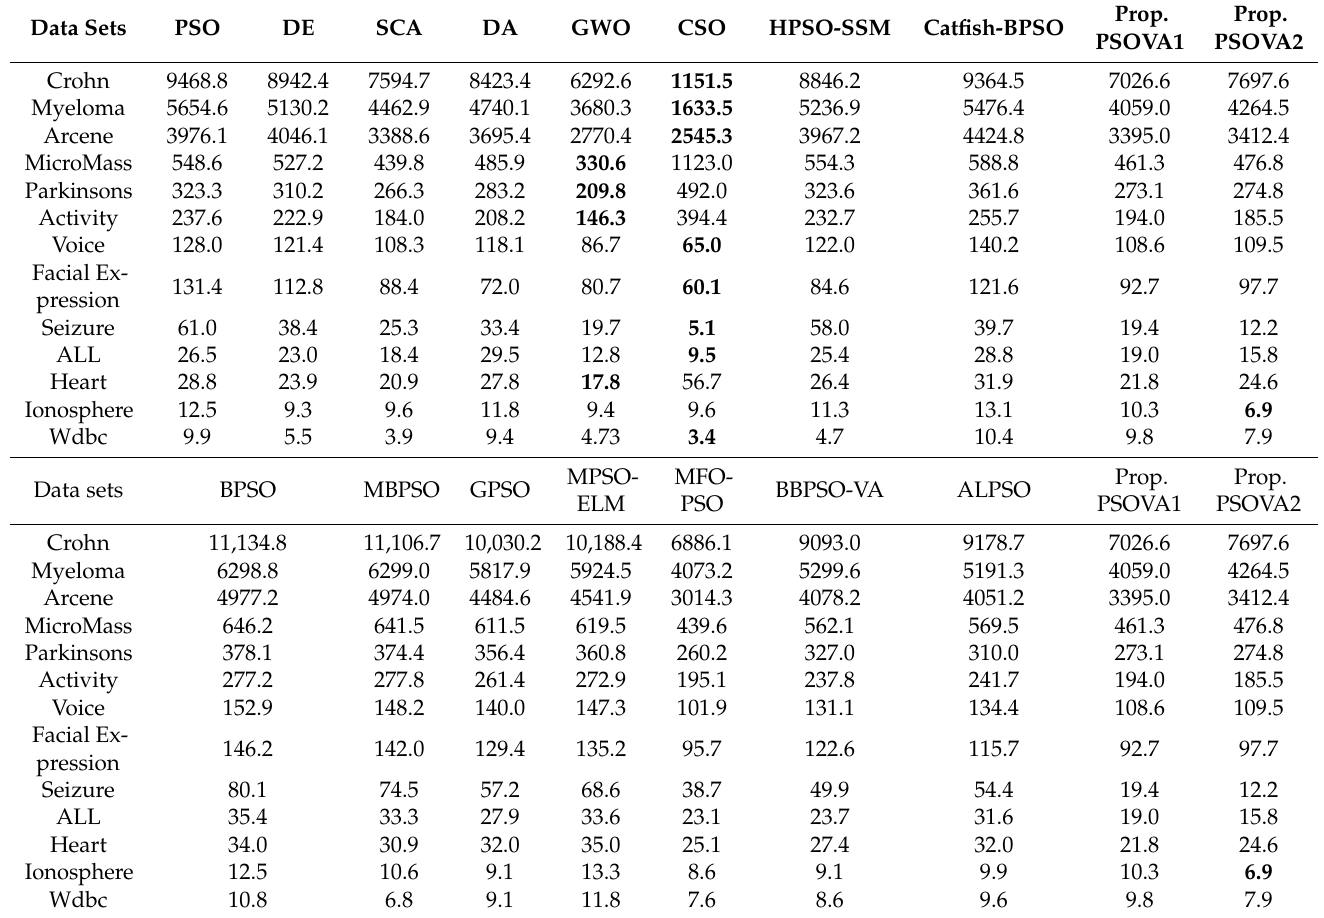
Table 8. The mean results of the number of selected features over 30